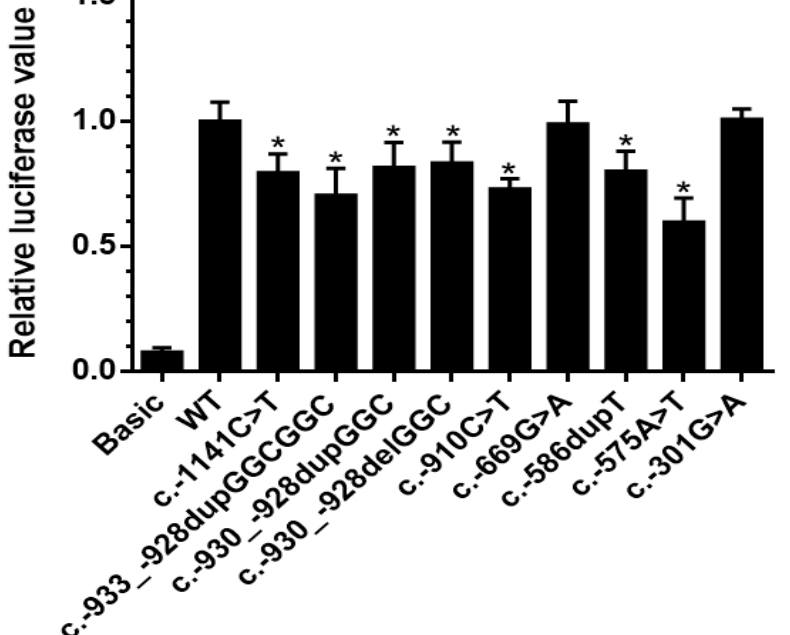
Figure 2. Transcriptional activity analysis of BMPR2 promoter variants. The transcriptional activity of nine BMPR2 promoter variants was compared with the wild-type BMPR2 promoter by dual-luciferase assay. Seven of the nine variants showed significantly reduced gene expression in comparison to the wild-type. Basic: pGL4.10 plasmid (without promoter, negative control), WT: wild- type, c.-930_-928delGGC: 11GGC repeats, c.-930_-928dupGGC: 13GGC repeats, c.-933_- 928dupGGCGGC: 14GGC repeats. Data are presented as mean ± standard error of the mean, normalized to the wild-type; p-value refers to the comparison between each mutant to wild-type; *: p < 0.05.